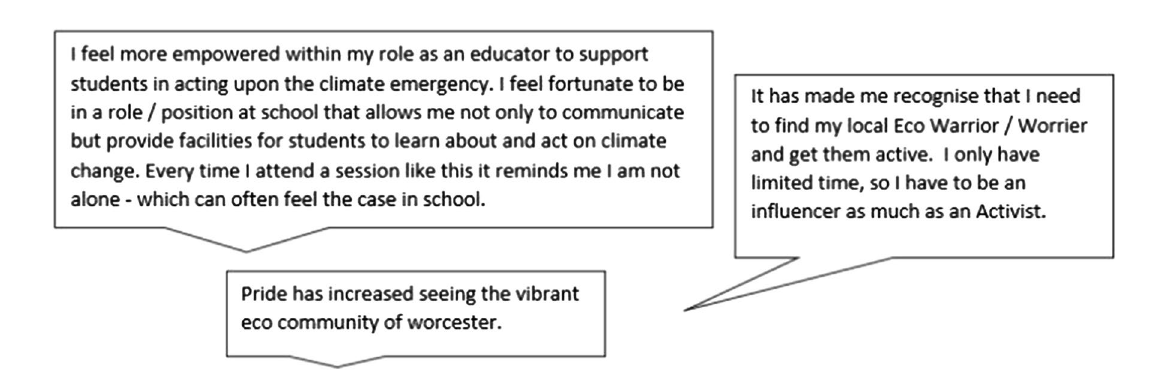
Fig. 6 Responses linked to